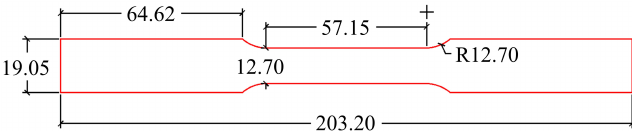
Figure 2. Nominal dimension of the tensile specimen (unit: